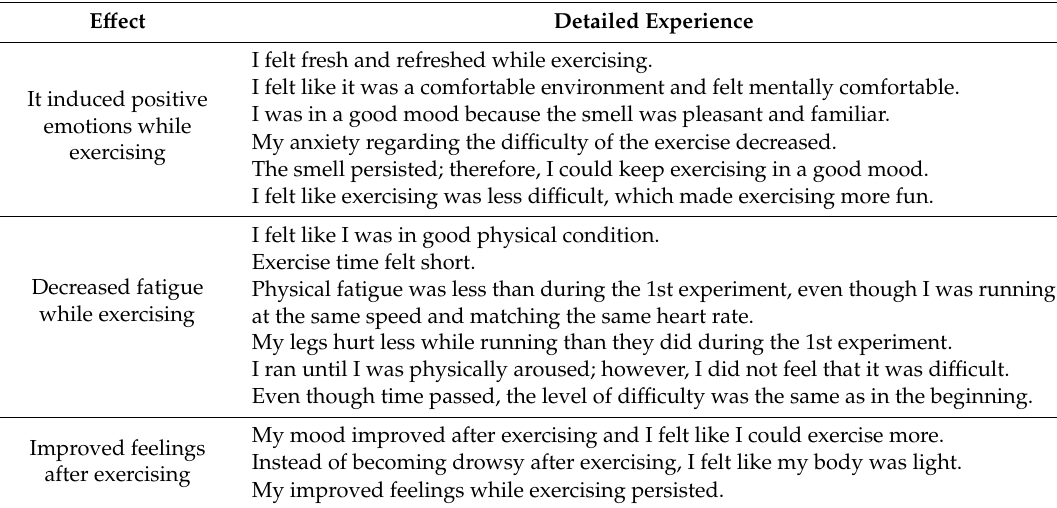
Table 2. Positive e ff ects of aromatherapy as described by